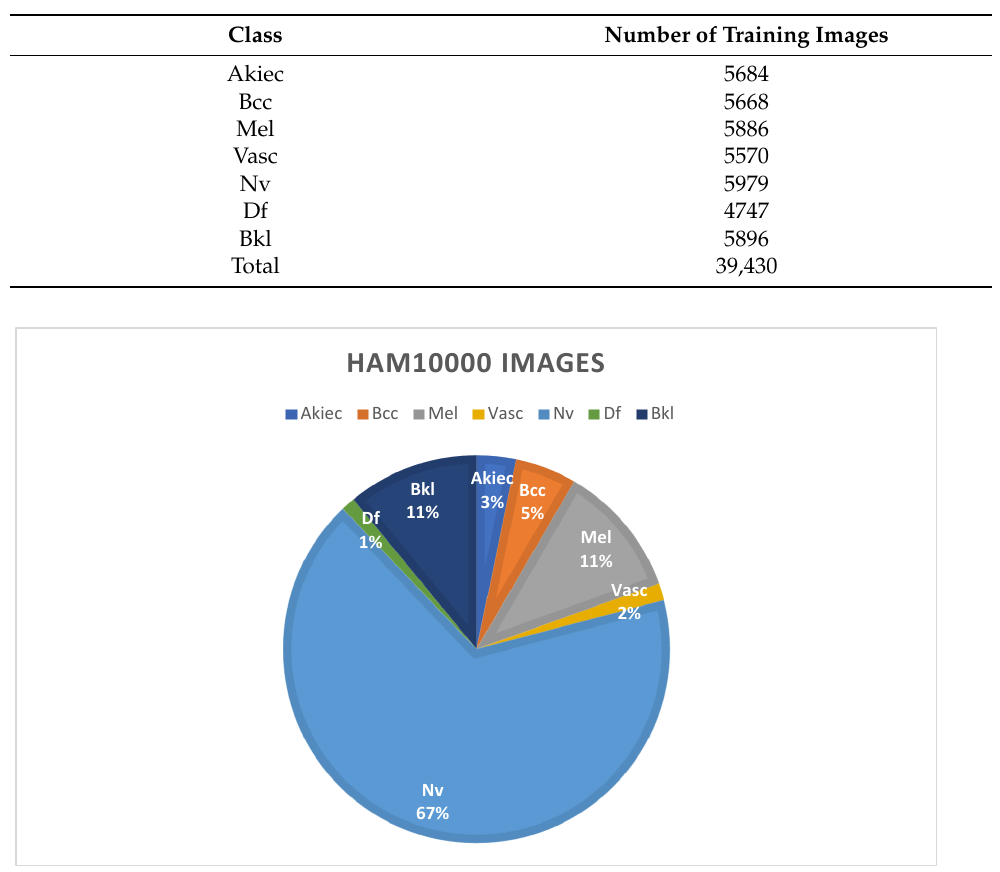
Figure 7. Unbalanced dataset before applying augmentation techniques.